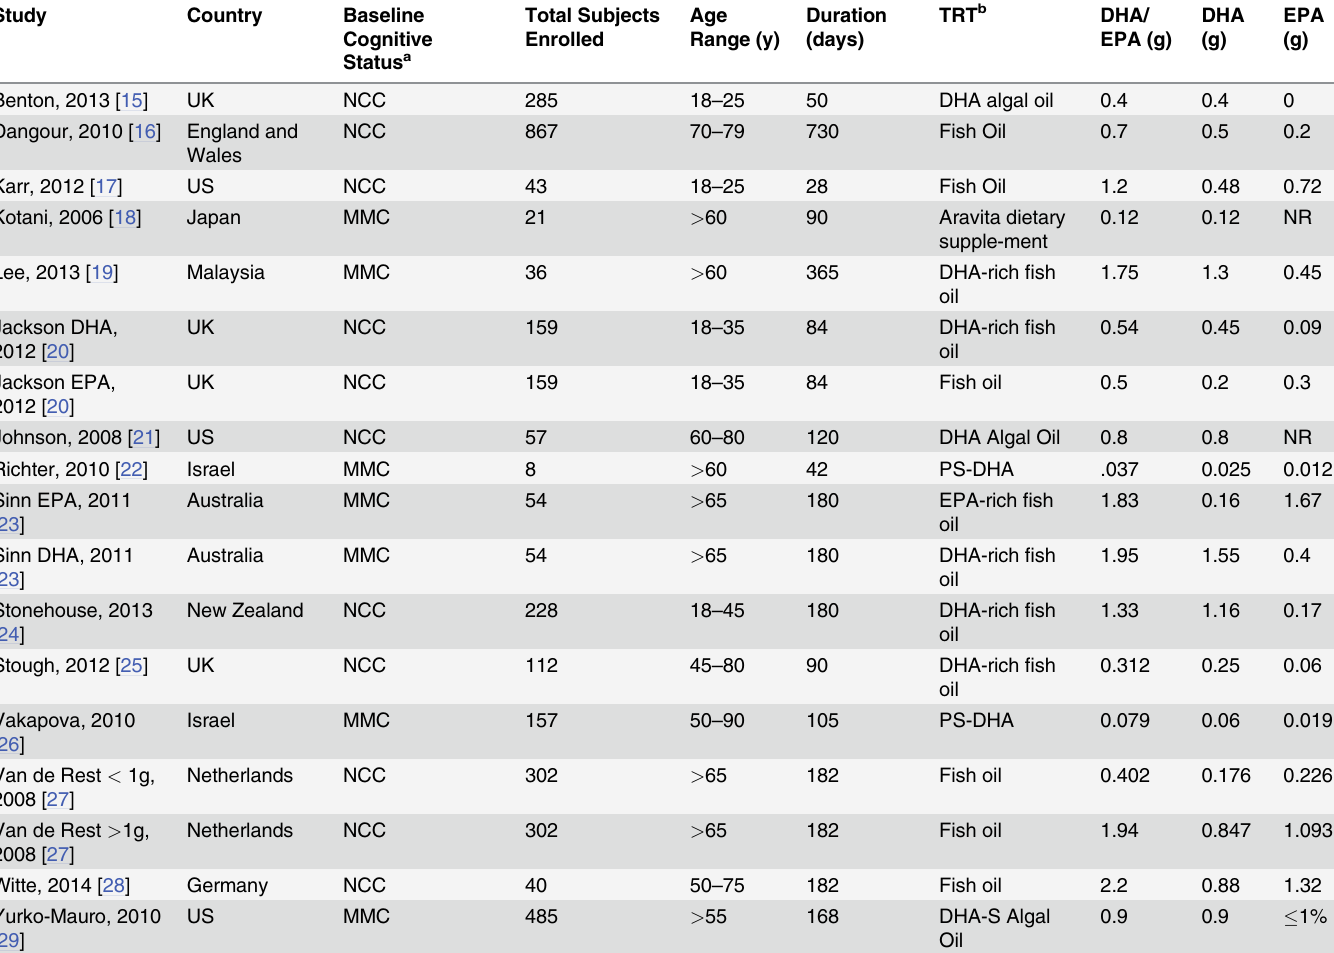
Table 1. Characteristics of Human Intervention Trials included in